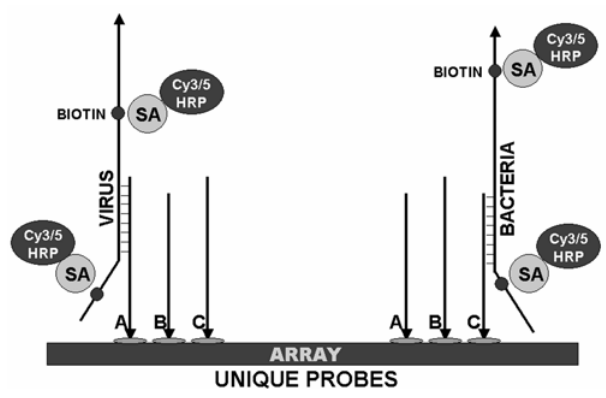
Figure 8. Hybridization and detection of viral and bacterial targets on microarrays. Biotinylated, single-strand target is hybridized to complementary probes on the microarray (A, B and C) and labeled by the addition of streptavidin (SA)-horseradish peroxidase (HRP) (for electrochemical detection) or streptavidin-Cy3/Cy5 (for fluorescent